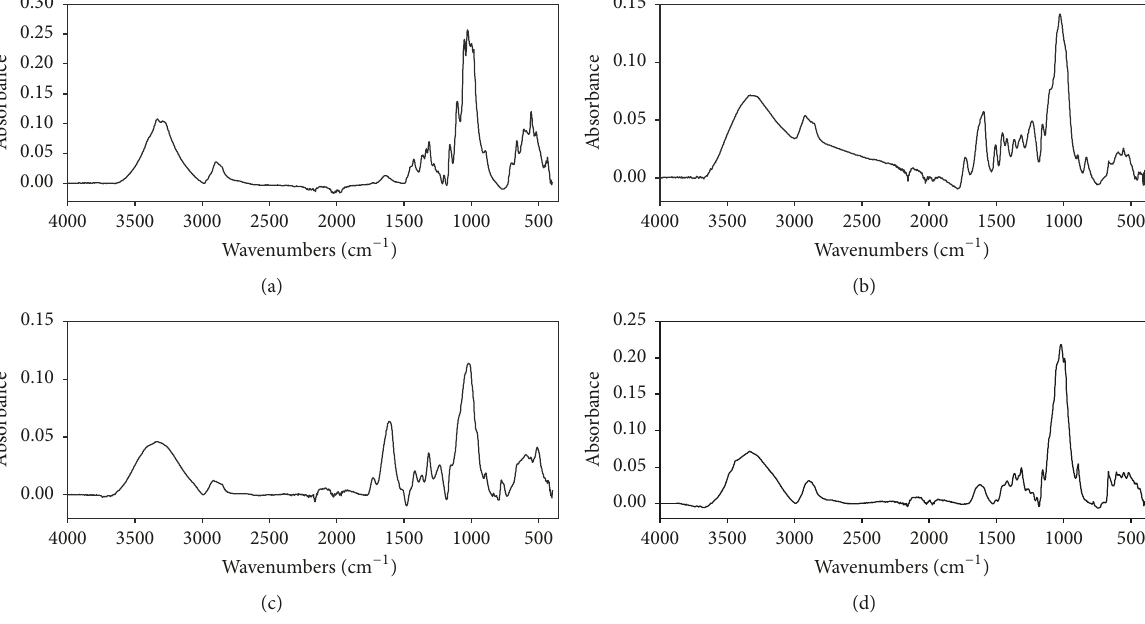
Figure 8: FTIR spectra of (a) cotton, (b) OOW, (c) agave fibers, and (d) 25% cotton: 75% OOW/AF